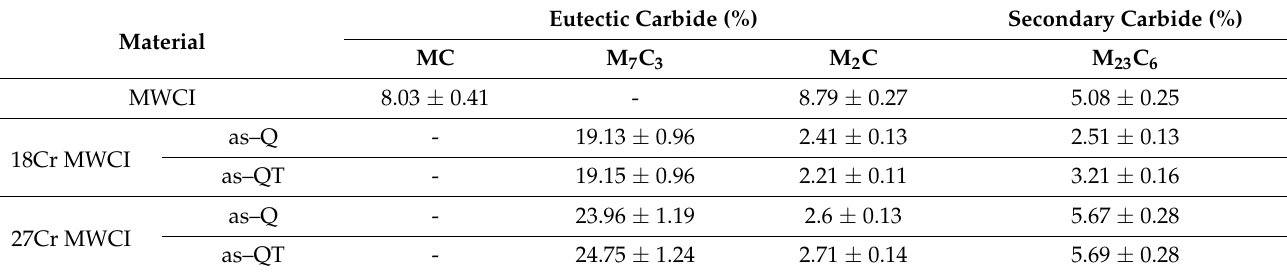
Table 2. The carbide volume fraction of each